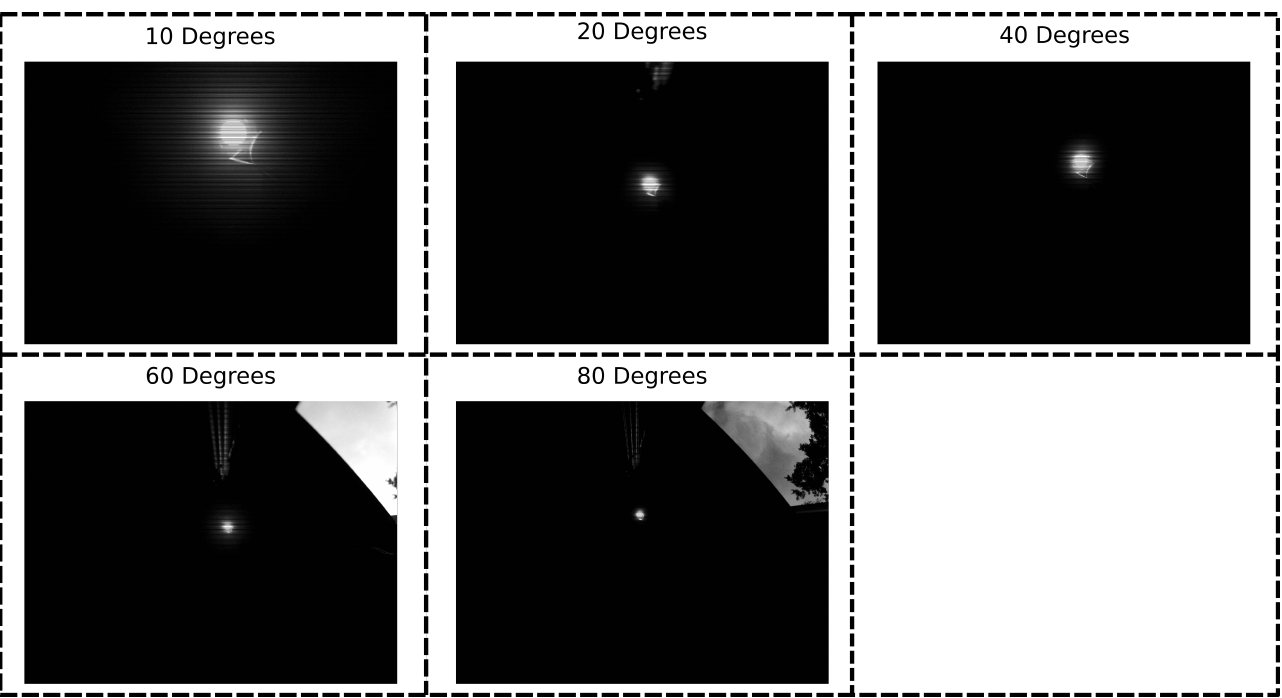
Figure 13. Example images for different FOV lenses.